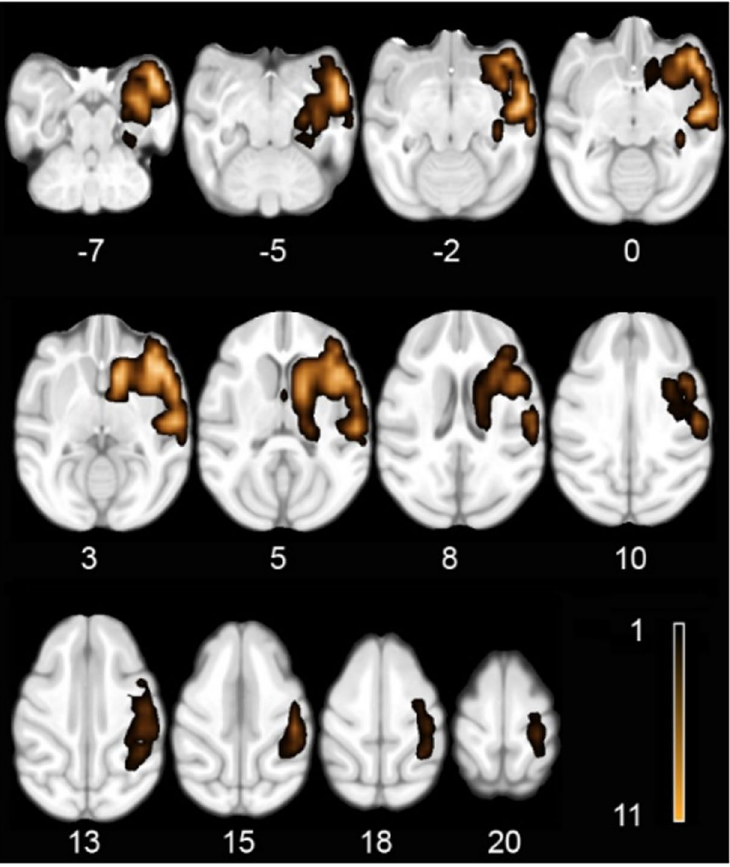
Figure 1. Horizontal sections including the z coordinate showing the stroke area mounted on the Montreal Neurological Institute (MNI) cynomolgus macaque atlas template. Note that the color intensity indicates the number of monkeys affected in the corresponding area as specified in the color